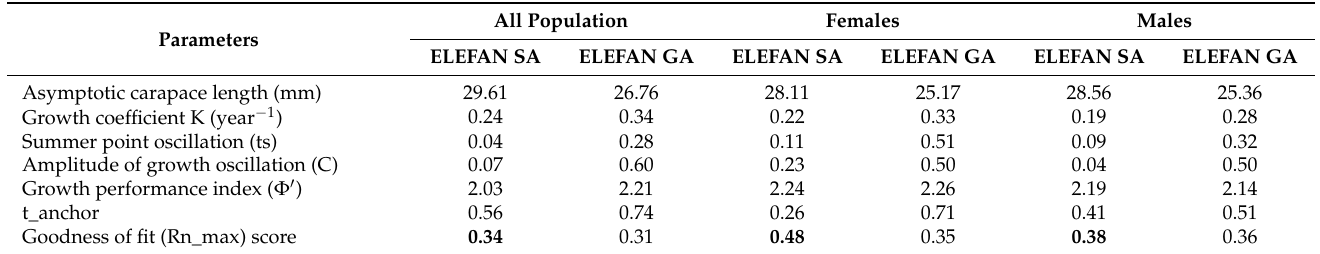
Table 4. Growth parameters and scores obtained from ELEFAN SA and ELEFAN GA for females, males, and all population. The selected model was based on the highest Rn_max values, marked in